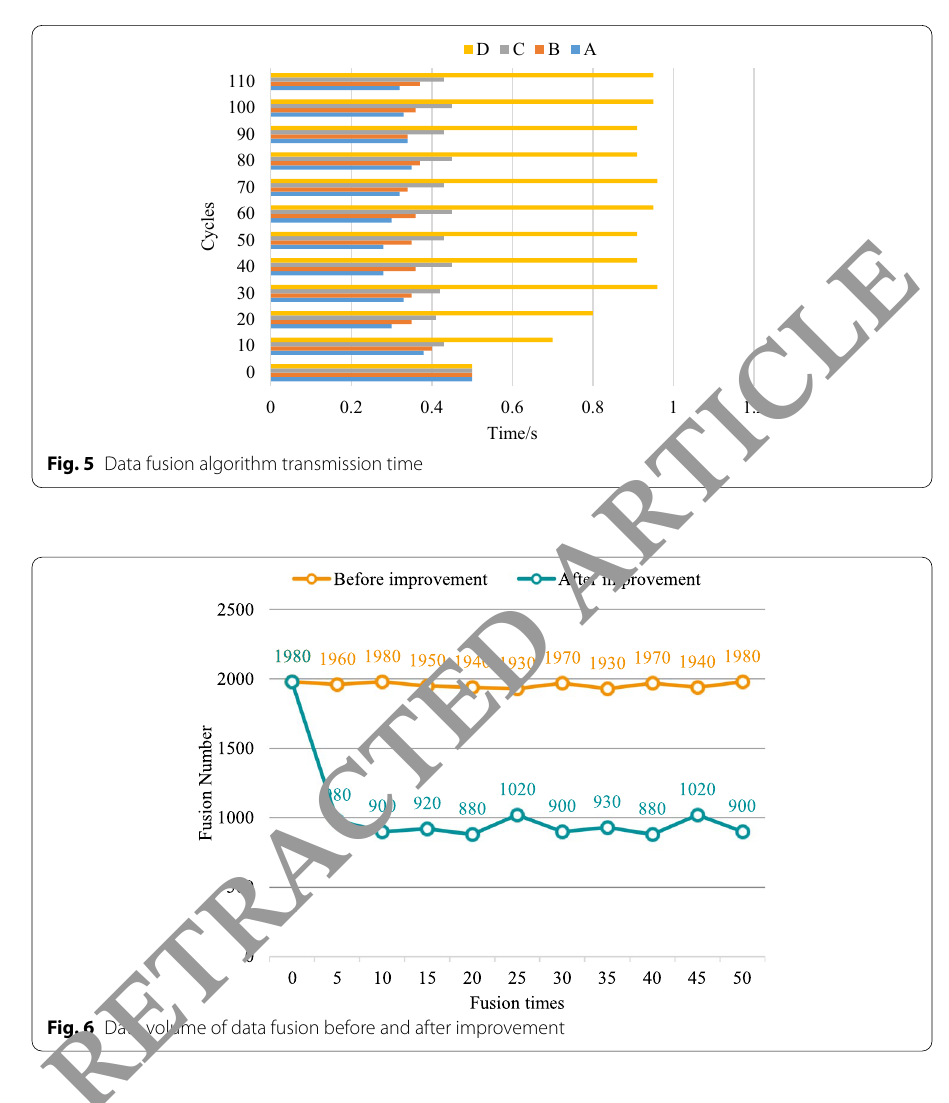
Fig. 6 Data volume of data fusion before and after